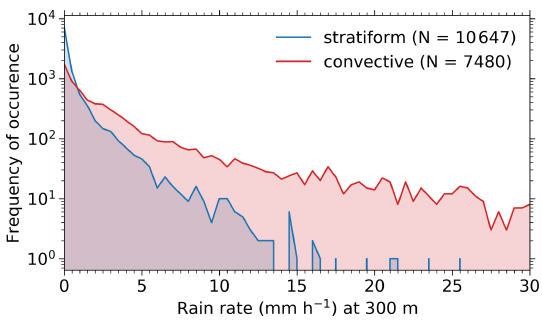
Figure 3. Frequency of occurrence of rain rate at 300m height for stratiform (blue) and convective (red) rain